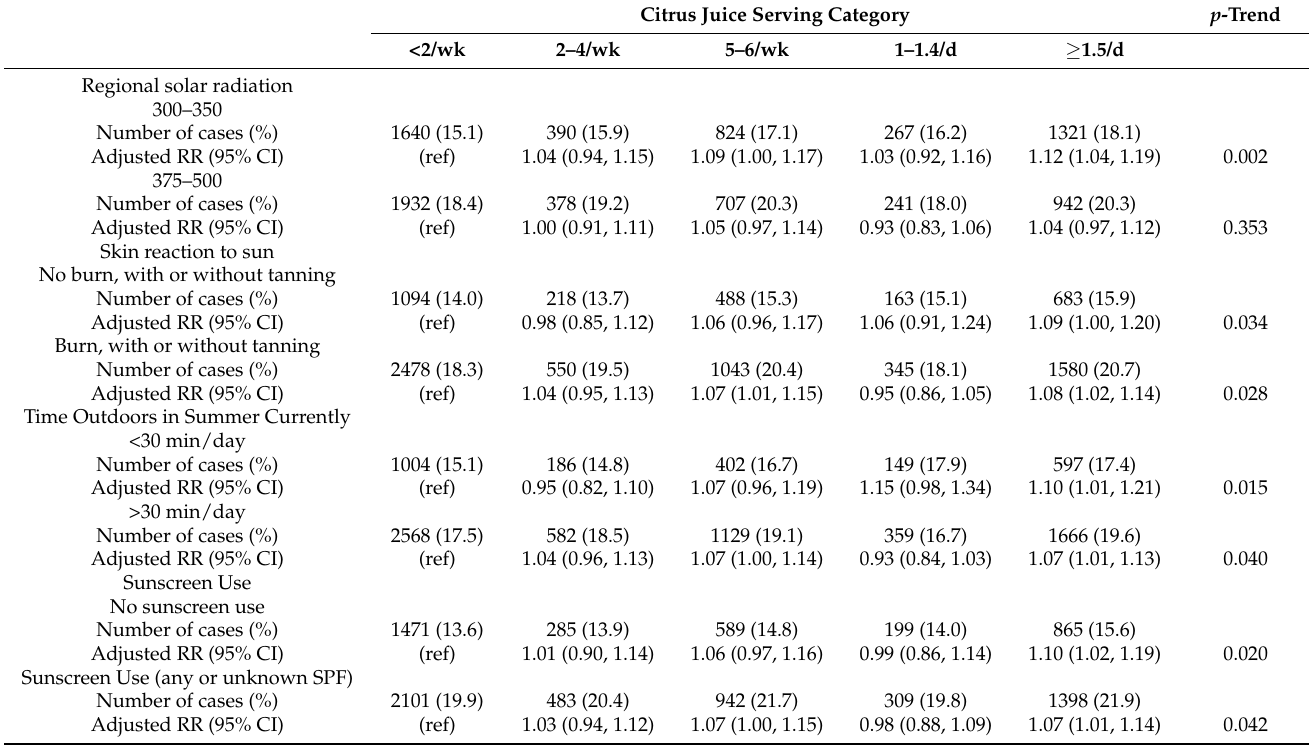
Table 3. The relative risk for incident non-melanoma skin cancer according to frequency of citrus juice consumption among Women’s Health Initiative participants ( n = 49,007) by subgroups of potential effect